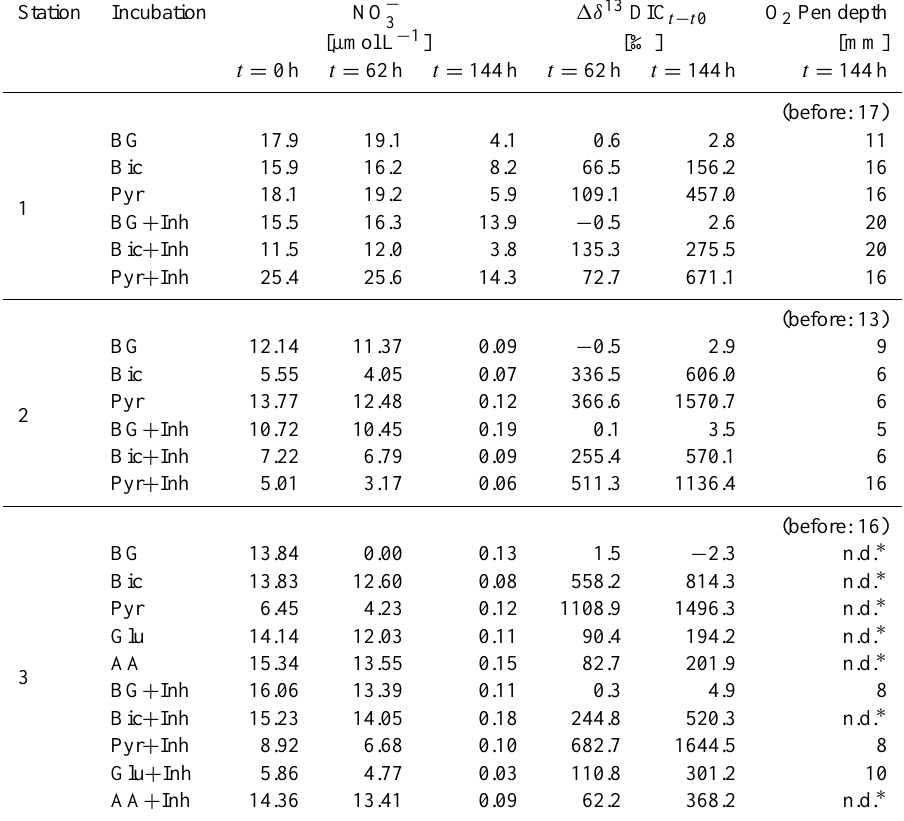
Table 2. The bottom water NO − concentrations and δ 13 DIC changes over the incubation time ( 1 t − t 0 ) , as well as oxygen penetration depths 3 measured after the incubations. In brackets, the average values of oxygen penetration depth for the cores before incubation. BG (background), Bic (bicarbonate), Pyr (pyruvate), + Inh (nitrification inhibitor nitrapyrine